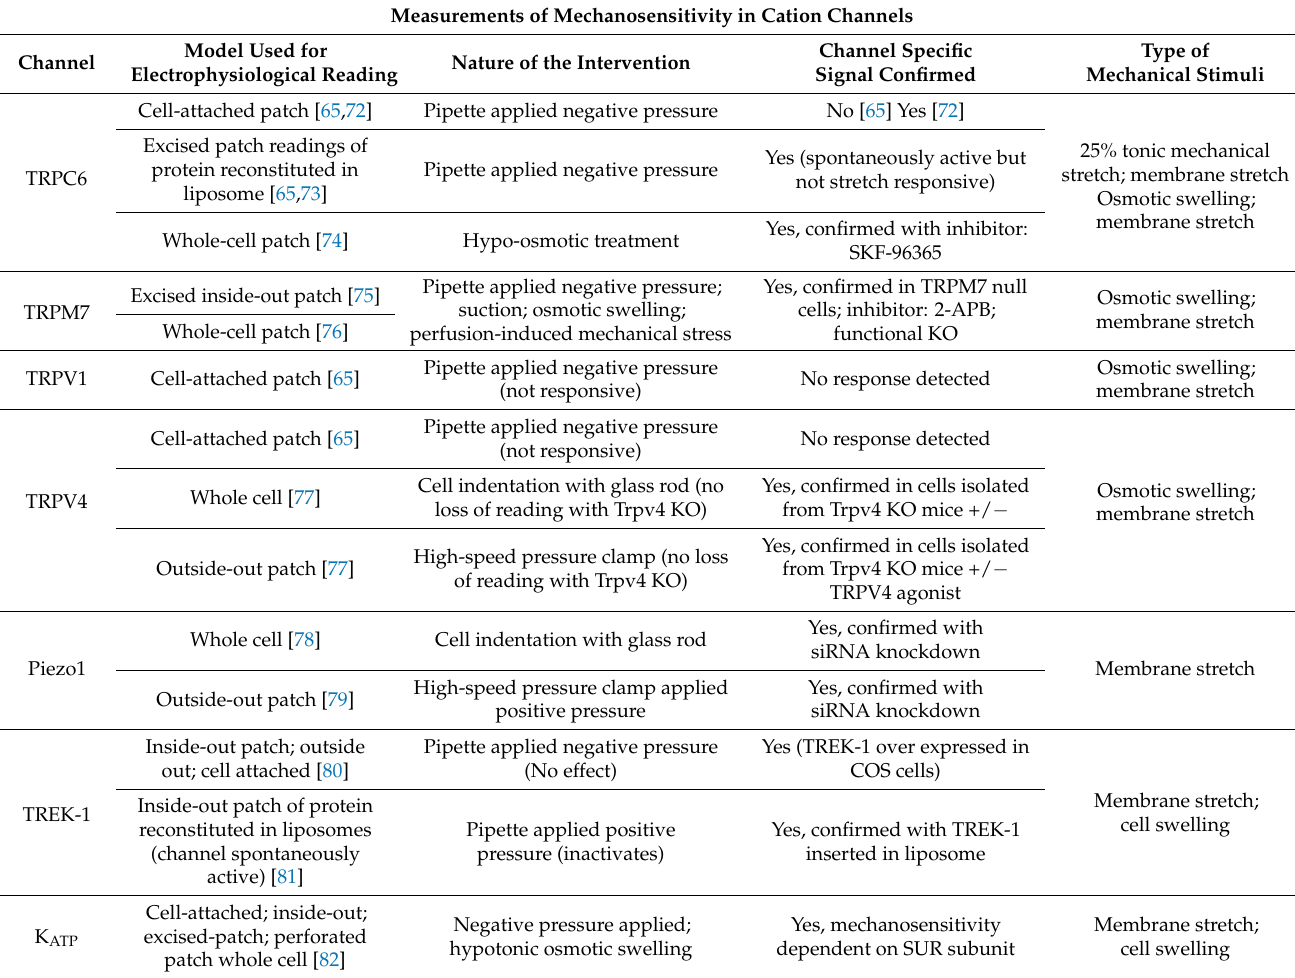
Table 1. Summary of electrophysiological detection of ion channel